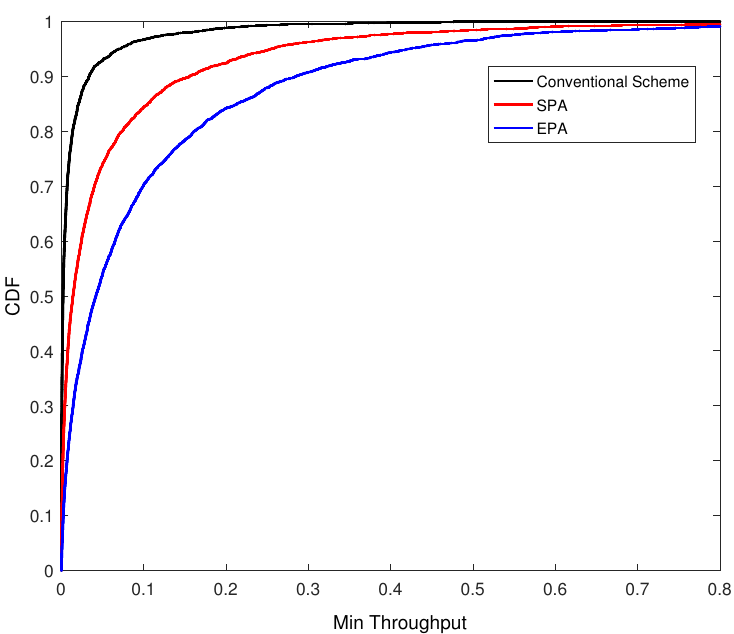
Figure 12. The CDF of min. uplink rate when M = 64 using MRC.